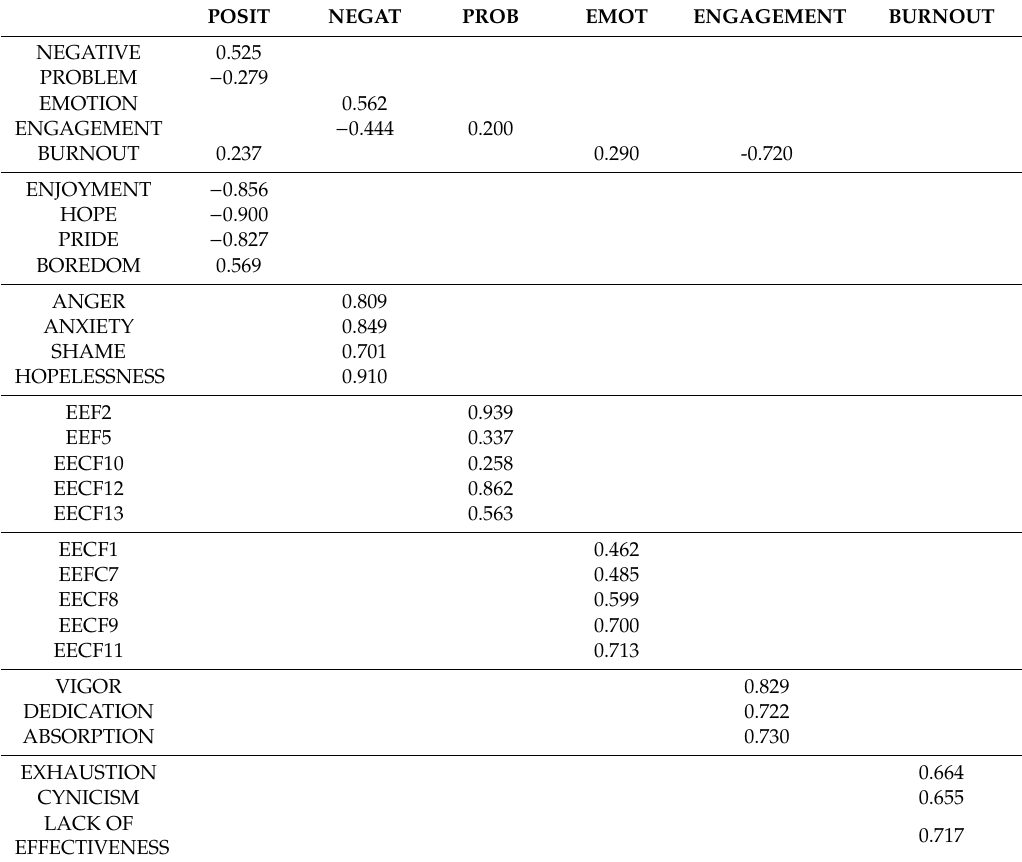
Table 4. Standardized Direct E ff ects (Default model). Class